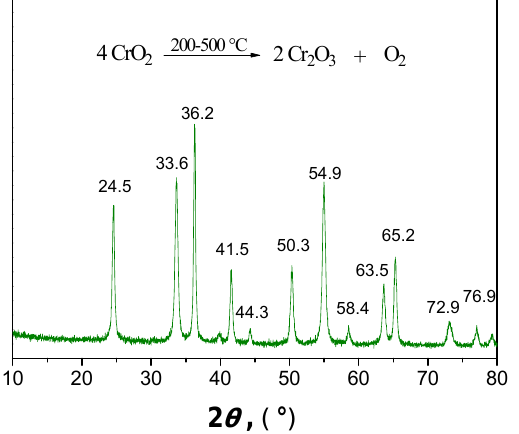
Figure 12. XRD pattern of solid product calcined at 400 °C for 8